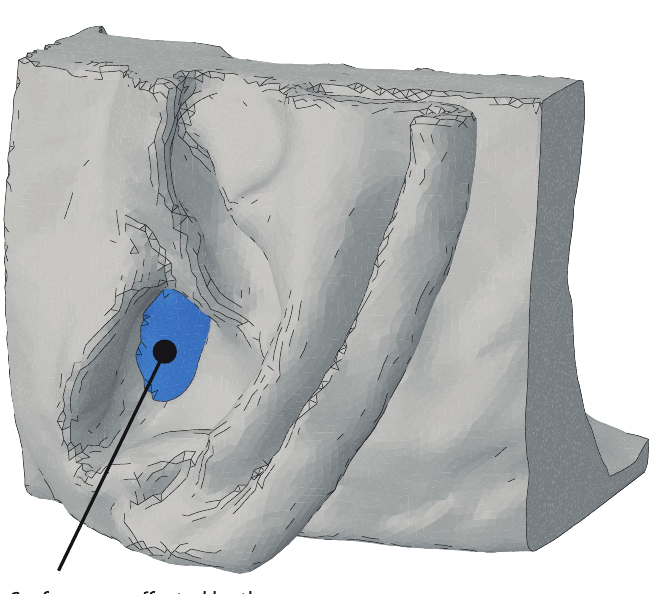
Figure 2. Surface area of the external auditory canal, where the pressure was applied.